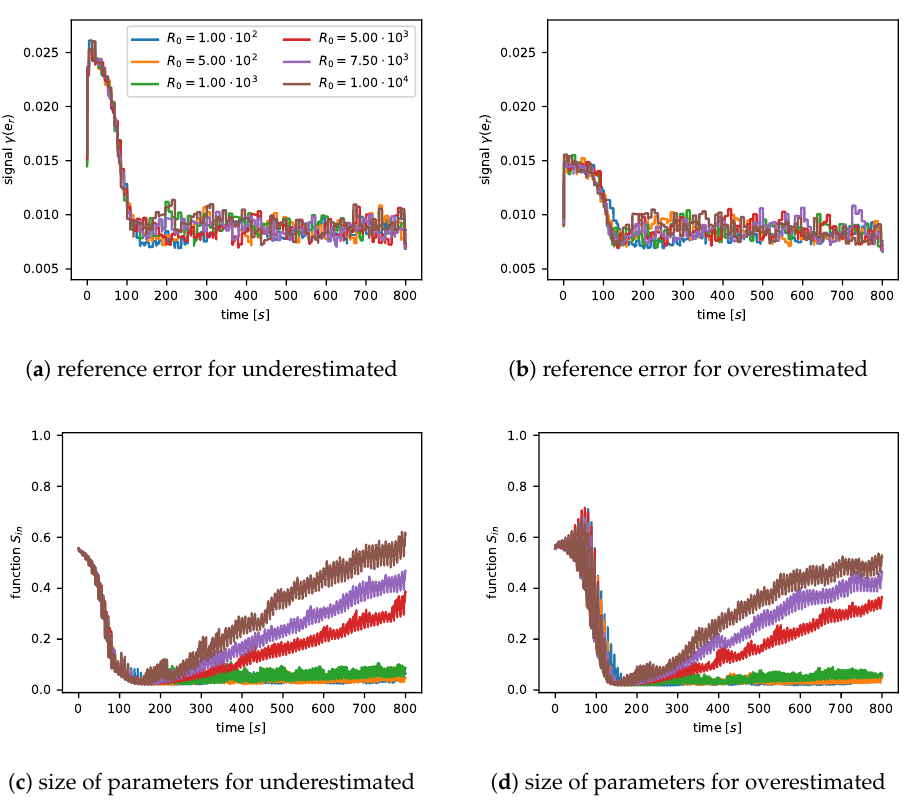
Figure 6. The transients of the control process for various values of R 0 (a large R 0 approximates an unconstrained covariance matrix P ).